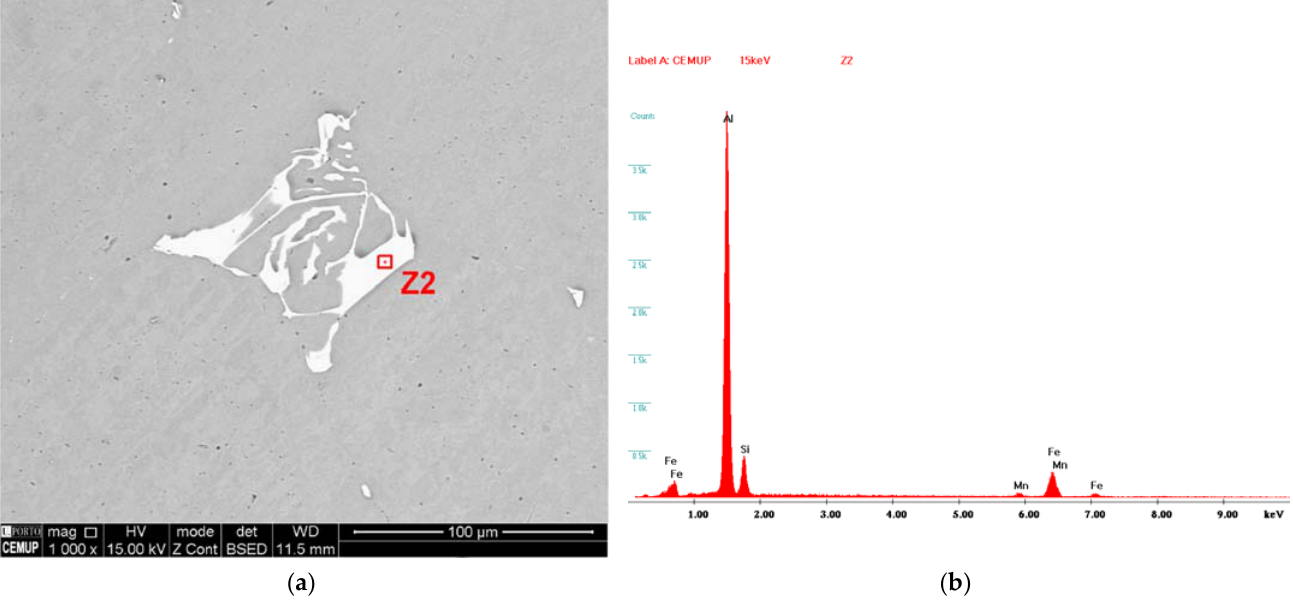
Figure 6. ( a ) Scanning electron microscopy detail of Al-EAn matrix area post-homogenization; ( b ) EDS analysis on the Chinese script.